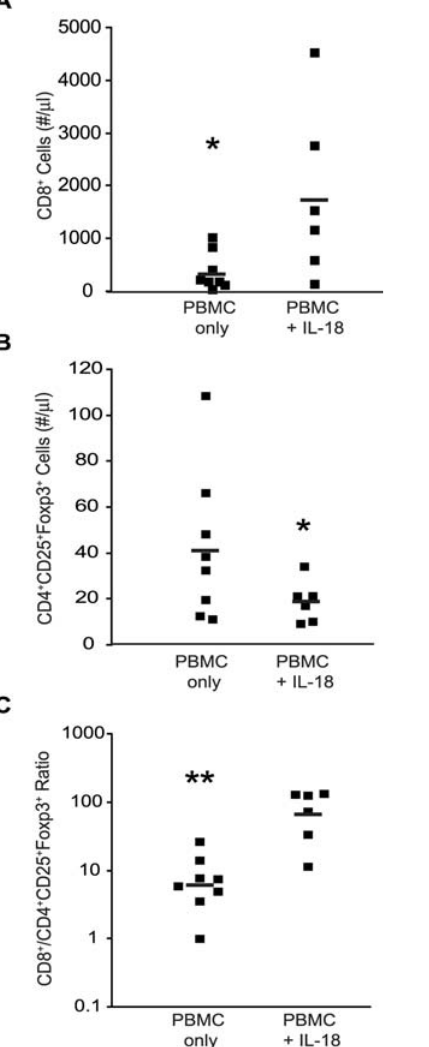
Figure 3. The Human IL-18-Mediated Decrease in Tregs is Not Restricted to NOD/ scid/ b 2 m null Mice. NOD/ scid /IL-2r c null (NOG) mice were injected with 5 6 10 6 human PBMCs, and 24 hours later, a three week course of daily subcutaneous injections of 15 m g recombinant human IL-18 was initiated. The absolute numbers of human CD8 + cells (A) and CD4 + CD25 + Foxp3 + cells (B) in the peripheral blood were determined using TruCount tubes. Values from individual mice are depicted. (C) The ratio of CD8 cell number to CD4 + 25 + Foxp3 + cell number for each animal in panels A and B is plotted on a log scale. In panels A and B, asterisks (*) indicate significant differences between mock- and IL-18-treated animals (n=6 to 8/group; p , 0.05). In panel C, asterisks (**) indicate p , 0.001.